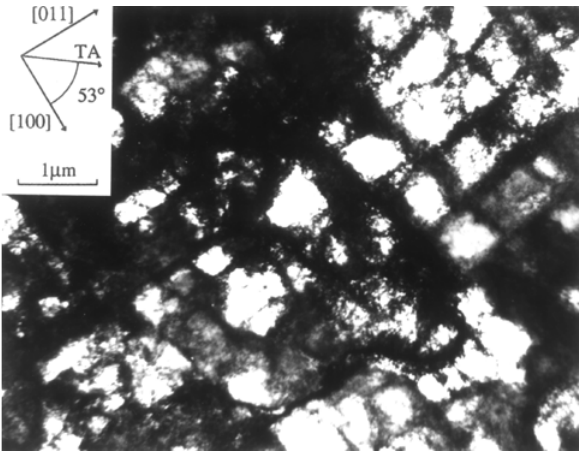
Figure 6. TEM observation of closed parallelogram cells developed near the rupture line during the second deformation in a grain with <1 1 0> axis normal to the sheet plane. The prestrain value in rolling is equal to 0.16 (TA, tensile axis).